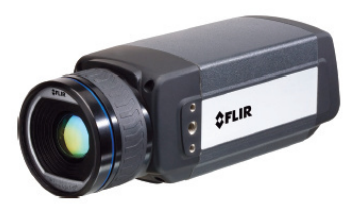
Table 1. Flir SC645 parameters